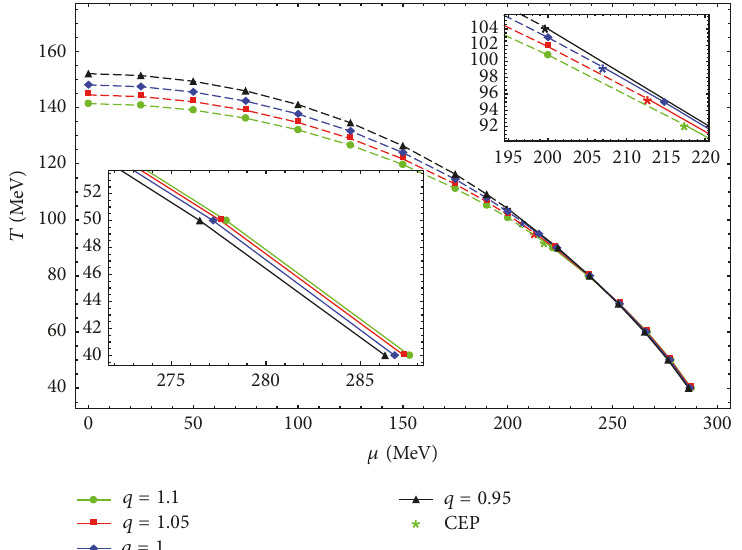
q = 1.1 q = 0.95 q = 1.05 Figure 4: Phase diagram of the 𝑞 -linear sigma model in the (𝑇,𝜇) plane for various 𝑞 values. The results are plotted for four different values of 𝑞 with the vicinity of the 𝑞 -dependent CEP and the low temperature part of the curves enlarged in the inset. For more details, the dashed line stands for crossover transition and the solid one the first-order transition. CEPs are shown as star